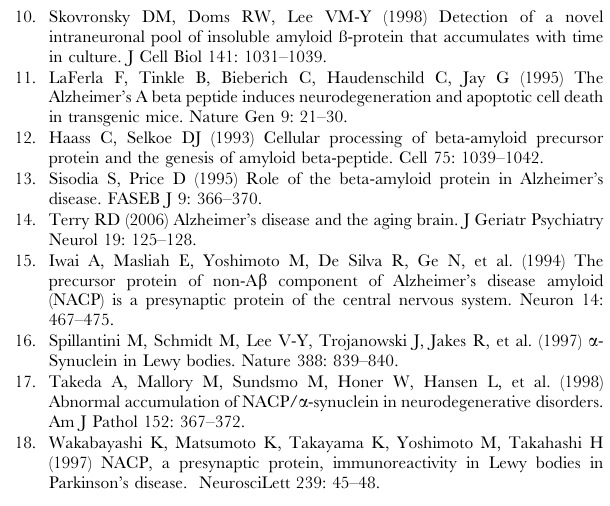
Figure S1 Molecular dynamics simulations of A b conformers at various time points. (A) Initial conformer; (B) 0.5 ns conformer; (C) 1.0 ns conformer; (D) 1.5 ns conformer; (E) 2.0 ns conformer; (F) 2.5 ns conformer; (G) 3.0 ns conformer; and (H) superimposed image showing all conformers in a composite image. Figure S2 Molecular dynamics simulations showing the changes in A b secondary structure over time. The first time zero line shows the amino acid sequence of A b 1–42, and the remaining lines depict the secondary structural characteristics. Figure S3 Molecular dynamics simulations of a -syn multimers with A b monomers and dimers. The 4 ns a -syn dimer and the 2 ns A b conformer were used for modeling all complexes. (A) Structural organization of one a -syn dimer complexed with one A b monomer. (B) Structural organization of one a -syn trimer complexed with two A b monomers. (C) Structural organization of one a -syn pentamer complexed with two A b monomers. (D) Structural organization of one a -syn dimer complexed with one A b dimer. (E) Structural organization of one a -syn trimer complexed with one A b dimer. (F) Structural organization of one a -syn pentamer complexed with one A b dimer. Figure S4 Increased levels of a -syn multimers in the presence of A b under in vitro aggregating conditions. Freshly-solubilized